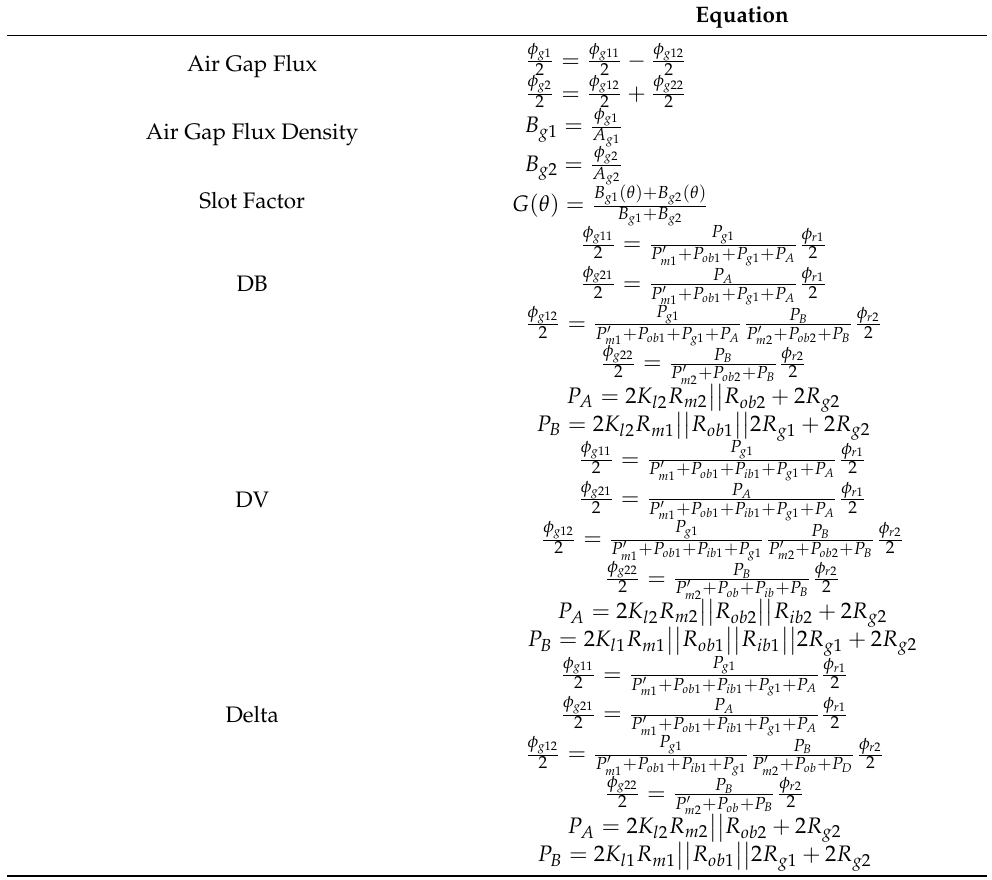
Table 2. Equations of air gap flux density distribution parameters according to double-layer rotor type.